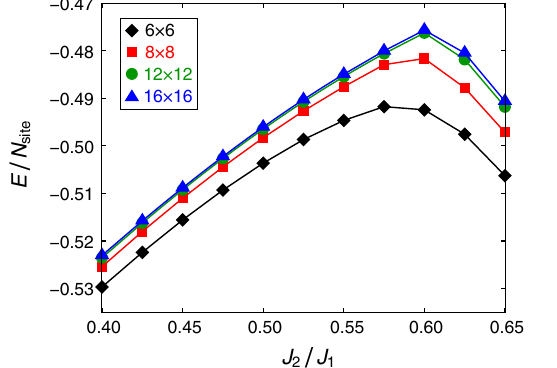
FIG. 13. J 2 dependence of RBM þ PP ground-state energy of square-lattice J 1 - J 2 Heisenberg model.